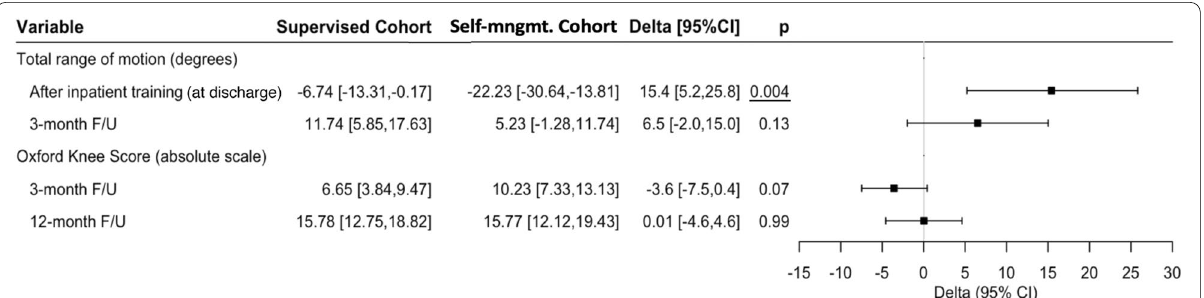
Fig. 3 Between-cohort differences of ROM and OKS with respect to preoperative baseline. Normally distributed data, in accordance with Shapiro Wilk-test, kurtosis and skewness are calculated using unpaired T-test. Significant p values underlined. Units: ROM: Range of Motion; F/U: Follow-up; CI: Confidence Interval; Self-mngmt.: Self-management